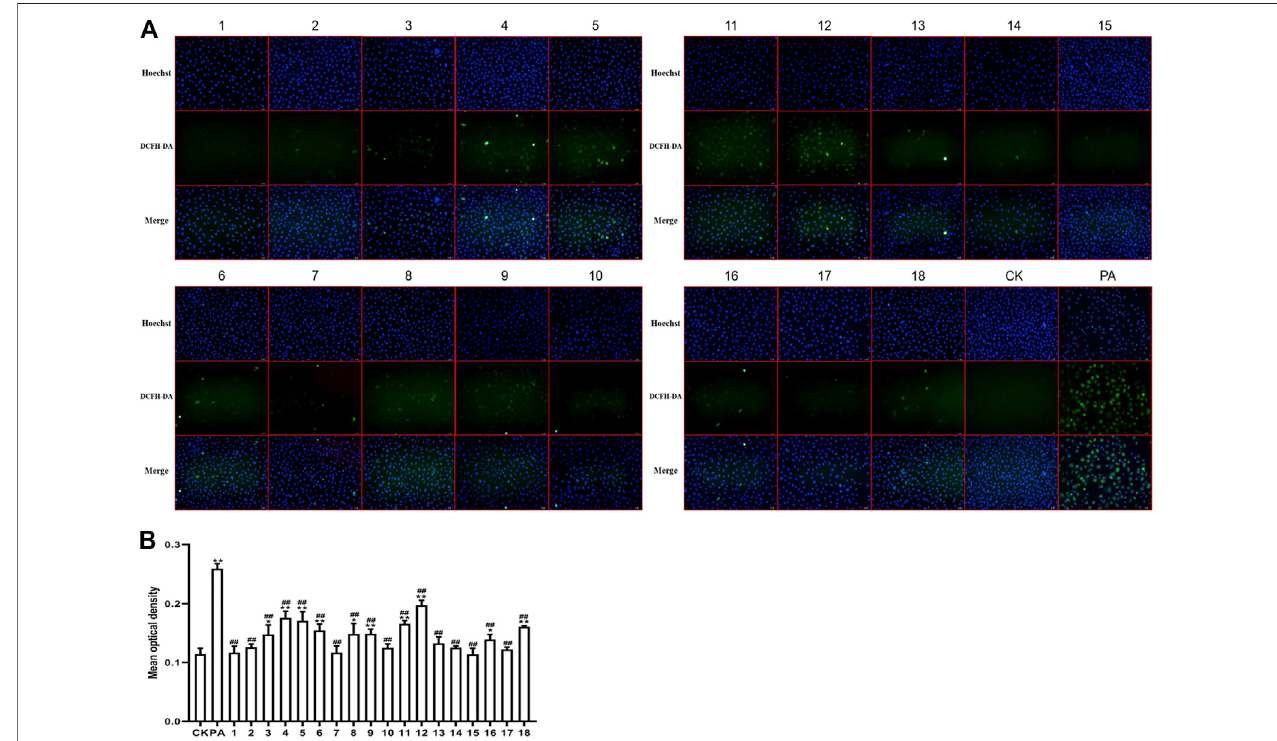
FIGURE 2 | ROS fl uorescence intensity (A) and scavenging activity (B) of Eighteen batches BBTD samples.